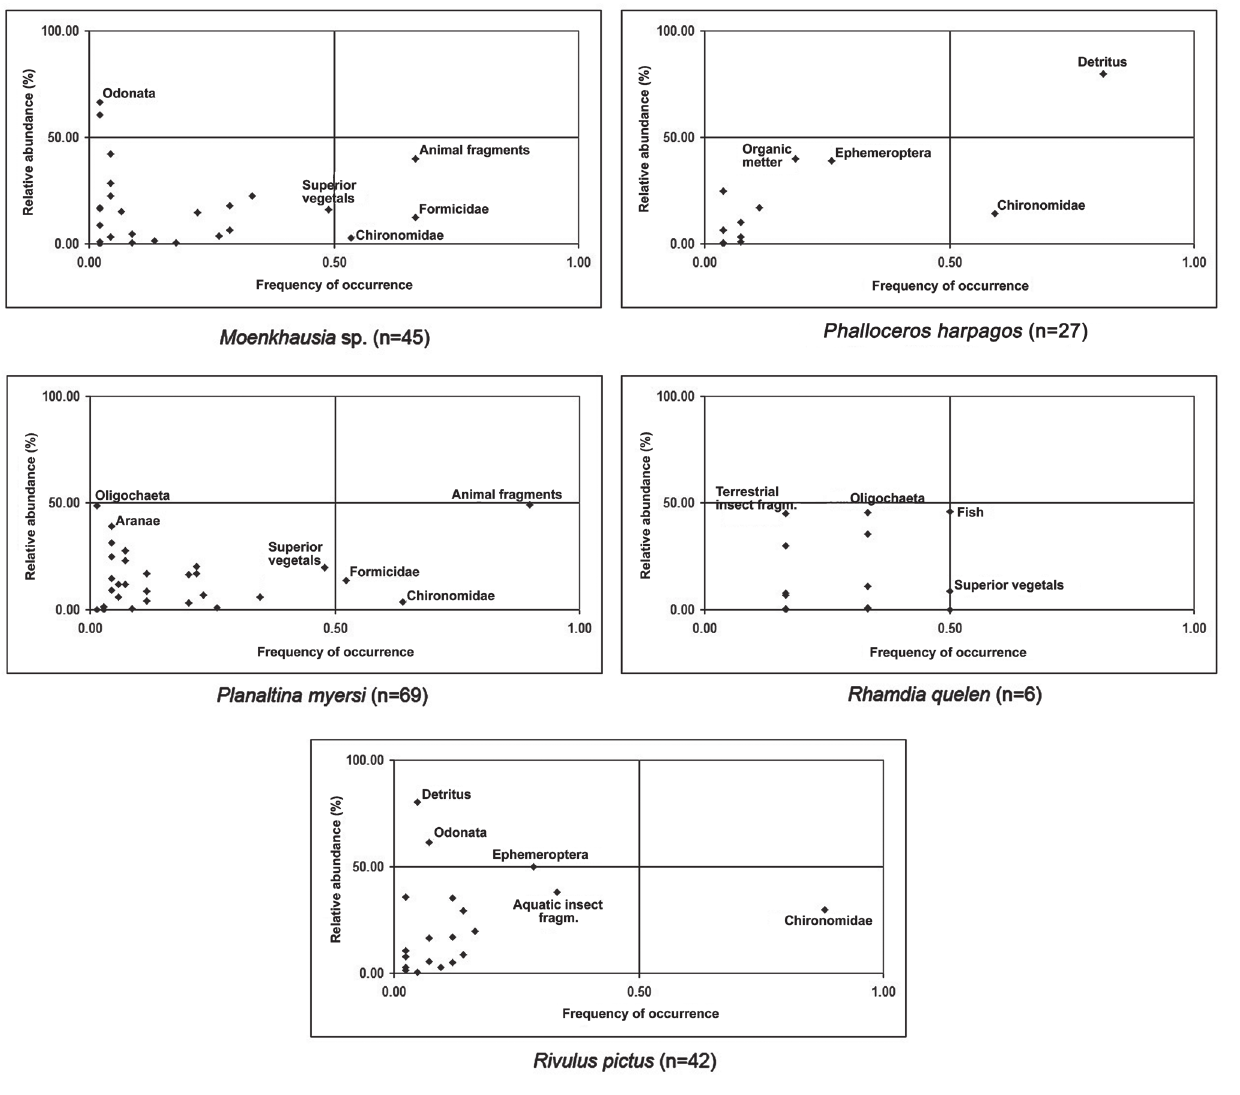
Fig. 5. Feeding items distributed according to the frequency of fish species occurrence (axis X) and relative abundance (axis Y), based upon the method proposed by Amundsen et al (1996): Moenkhausia sp. , Phalloceros harpagos, Planaltina myersi, Rhamdia quelen and Rivulus pictus . The number of analyzed stomachs is shown in